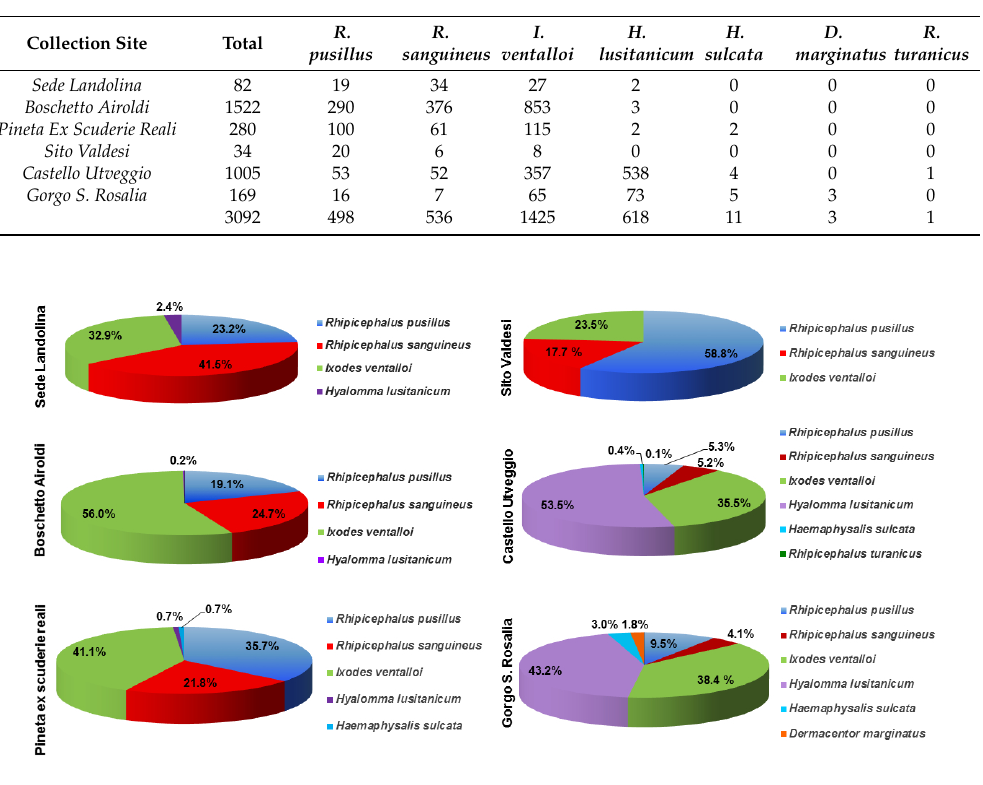
Figure 7. Percentage values of each tick species in the different collection